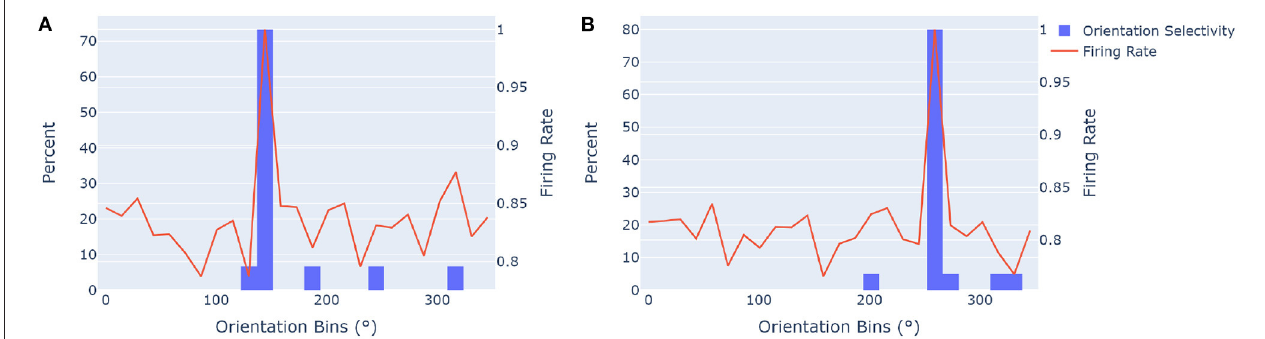
FIGURE 5 | Orientation selectivity is measured by evaluating the percentage of estimated orientations of classified objects that fit into the receptive fields of the ideal model, and how the cumulative firing rate across all objects compare to it. Orientation selectivity is an important part when mentally rotating objects to match their stored representations in order to recognize them. We used a network with 25 grid cell modules and 13 cells per axis. The orientation selectivity was determined for sets of objects rotated by (A) 10 and (B) 18 positional shifts for the ideal model, and thus associated with the 144 ◦ (360 × 10 The orange trace shows the normalized sum of all firing rates in all the primary directions of rotated modules over the specified sets of objects, giving insight into how the model correctly estimated orientations for most objects. (A) The orientational selectivity of an equivalent module rotation of 144 ◦ is shown. Approximately 73 % of objects that had the highest firing rate in this direction (estimated orientation) fell in the ideal orientational receptive field of this configuration. The normalized firing rate has a primary peak that corresponds with the histogram. (B) The orientational selectivity for a module rotation of approximately 259 ◦ is shown, with 80 % of object orientations correctly identified within the ideal orientation